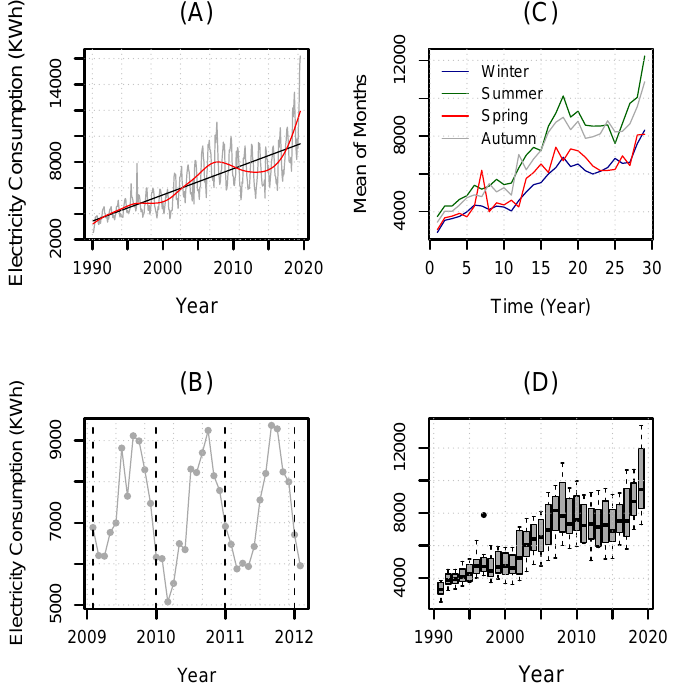
Figure 1. Specific characteristics of the electricity consumption time series (kWh): ( A ) electricity consumption time series for the period from January 1990 to June 2020 (original time series–gray; linear curve–black; nonlinear curve–red); ( B ) annual periodicity for the period from January 2009 to December 2012; ( C ) seasonal plot for the period from January 1990 to June 2020 (winter–blue; summer–dark green; spring–red; autumn–gray), and ( D ) box-plots for yearly observation for the period from January 1990 to December